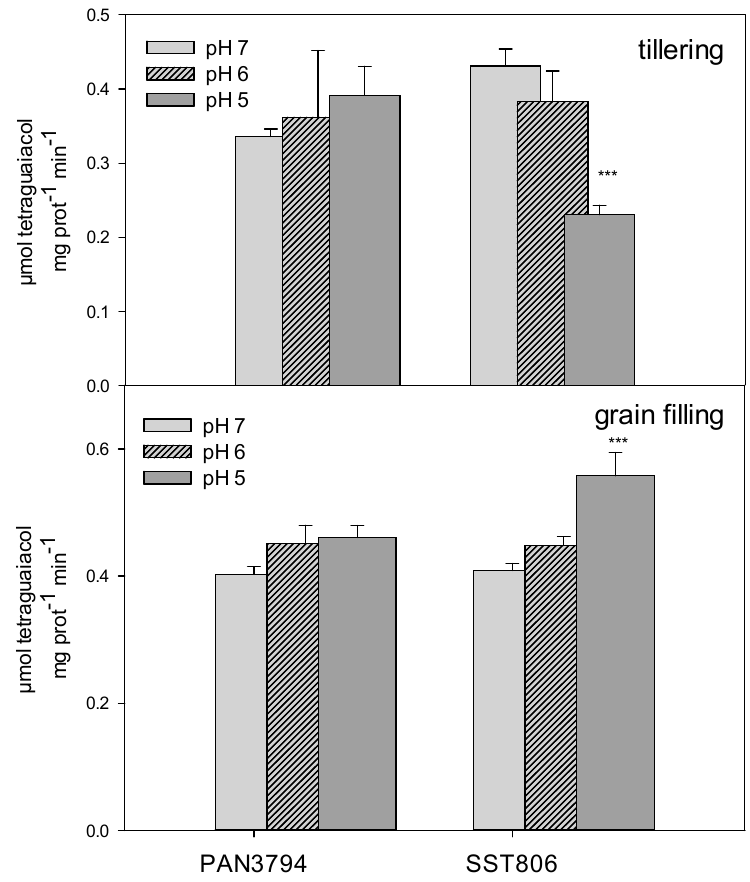
Figure 3. The peroxidase (POD) activity of PAN3497 and SST806 grown at three soil pH levels (pH 7, 6, and 5), with two sampling times (tillering and grain filling). Values are the averages of three biological and technical repetitions ± SE. Significant difference compared to pH 7: *** p < 0.001.